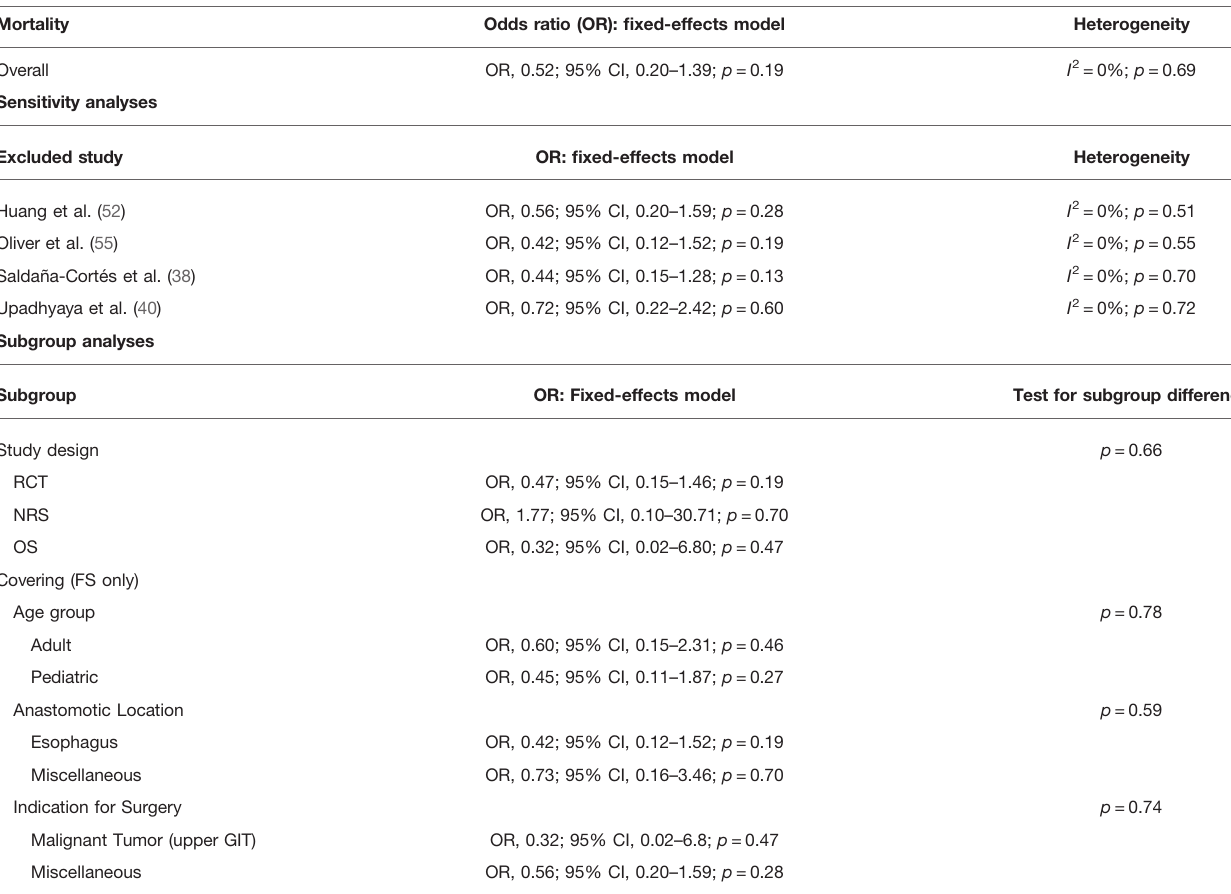
TABLE 8 | Fixed-effects meta-analysis for postoperative mortality in the intervention and control goup. Mortality Odds ratio (OR): fi xed-effects model Heterogeneity Overall OR, 0.52; 95% CI, 0.20 – 1.39; p= 0.19 I 2 =0%; p= 0.69